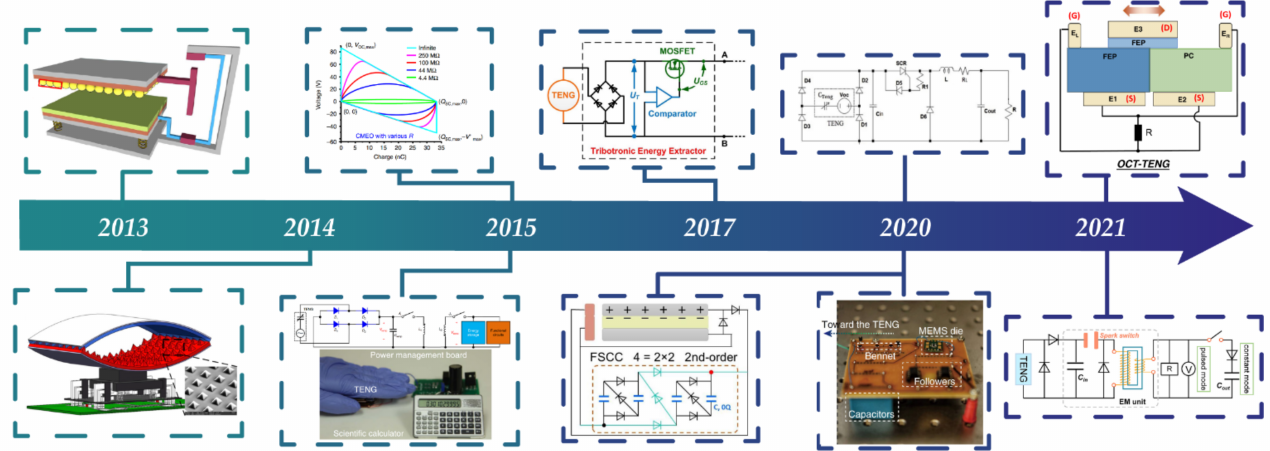
Figure 1. Brief timeline of the switching power management methods for triboelectric